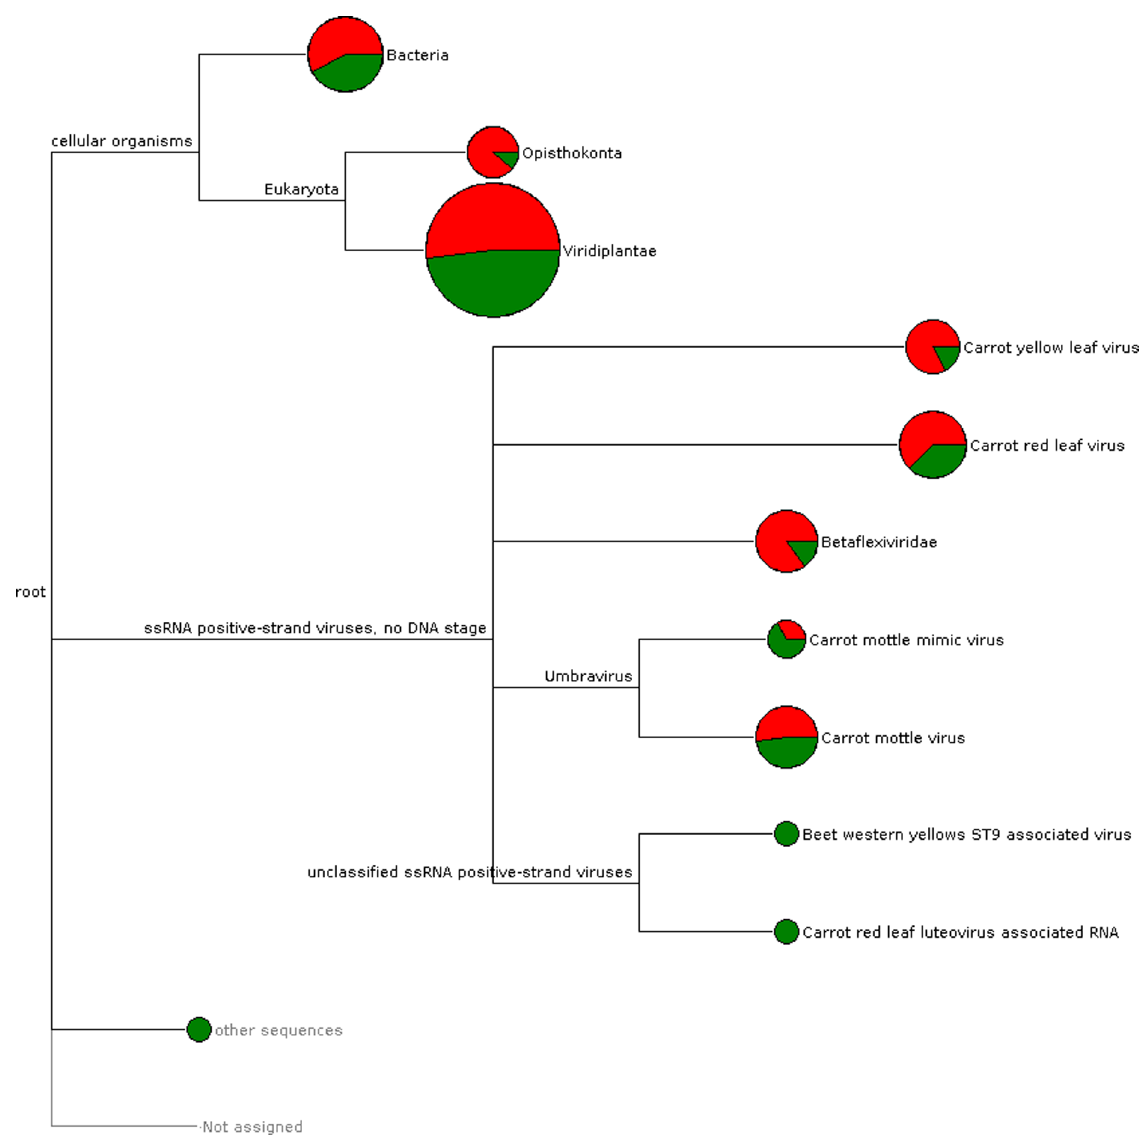
Figure 3. MEGAN derived Phylogram showing the putative identification of contigs in the Sequencing data. Circle size is derived from the number of contigs assigned to each taxa Red: affected, Green: unaffected.